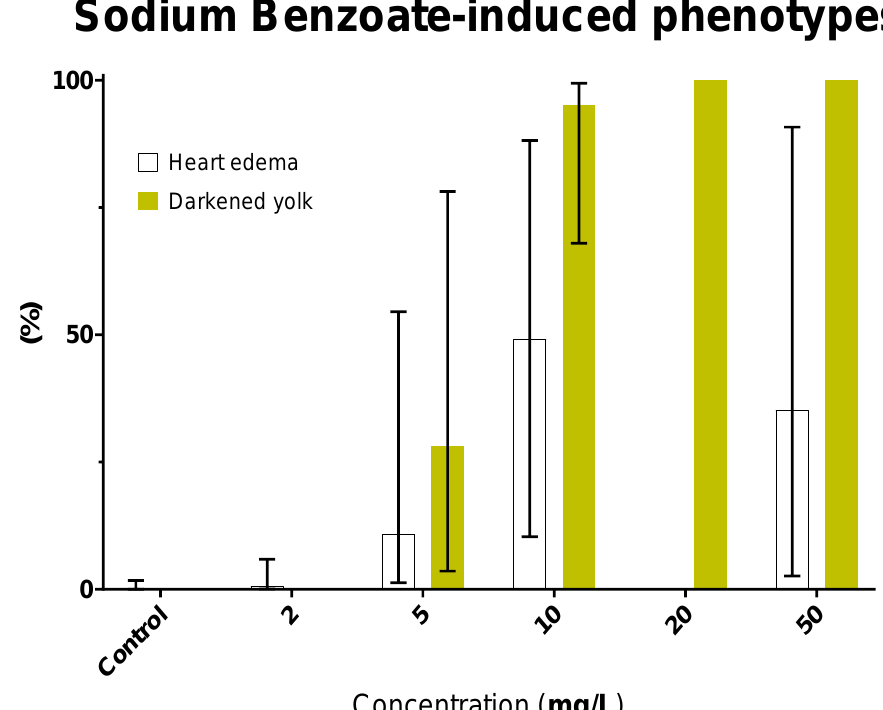
Figure 7. Prominent phenotypes in zebrafish larvae after four days of exposure to SB. Error bars showing 95% prediction interval.